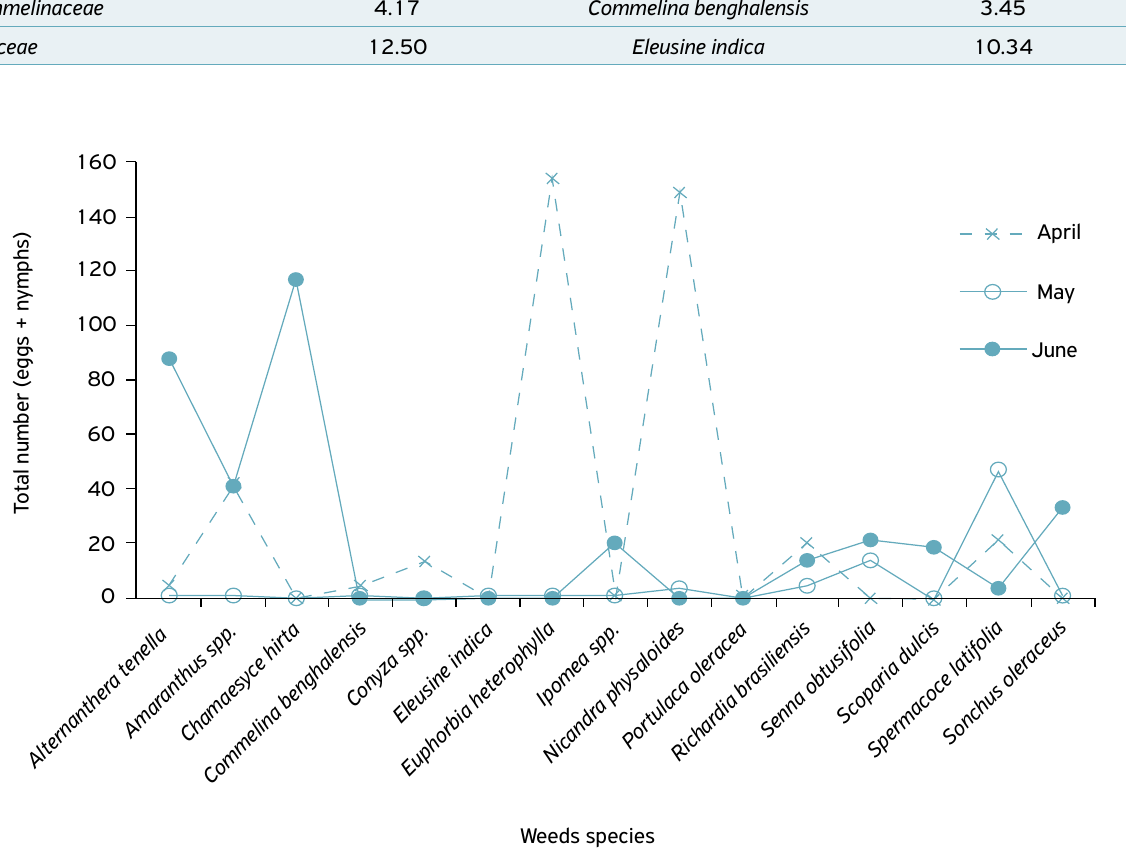
Figure 1. Bemisia tabaci biotype B fluctuation in the weeds present in the FM 975 WS cultivar cotton crop from April to June 2015, Sinop, Mato Grosso,